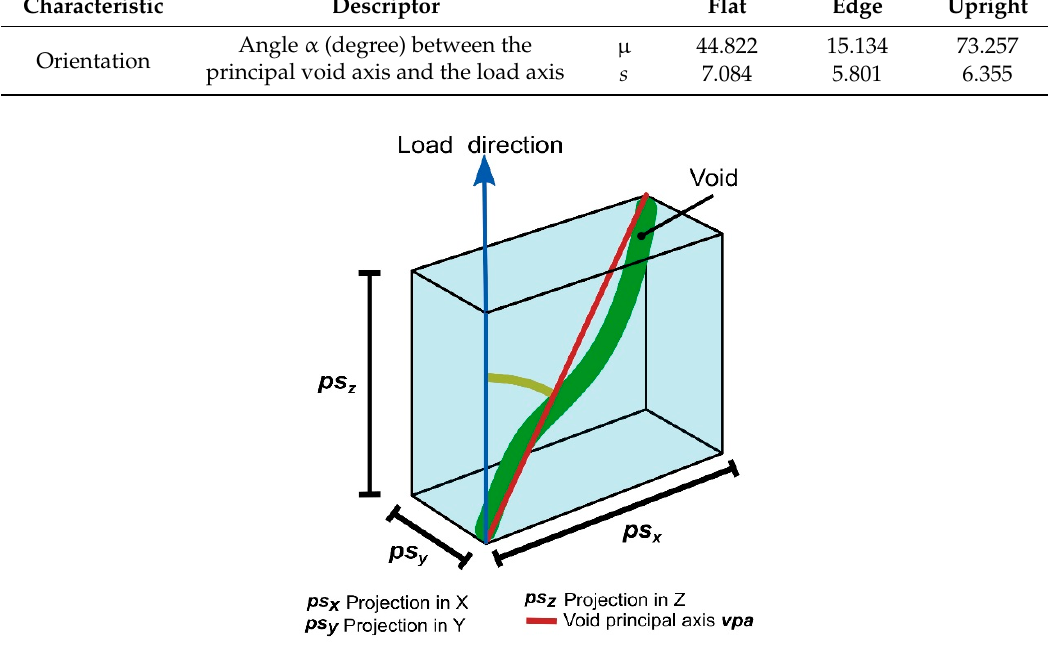
6.355 Figure 7. Void size ( d ) and orientation angle ( α ) relation. The black line indicates the CT resolution limit due to the used parameters and sample size. 3.3. Sensibility and Specificity Voids with an orientation angle in the range { α : α > μ ( α ) + s ( α )} or { α : α < μ ( α ) − s ( α )} according to the corresponding build direction are likely misrelated to a distinct build direction. To validate the mean void orientation angle range for every sample, the sensitivity λ [81] is calculated for the established range. The value of λ is a statistical measure that gives the percentage of void angles correctly identified within the established angle range. For every orientation, e , f , and u , there is a collection A ( α ) of measured void angles with mean μ ( α ) and s( α ) standard deviation corresponding to that orientation, and A ¬ ( α ) (w.r.t. μ ¬ ( α ),s ¬ ( α )) and A ¬ ( α ) (w.r.t. μ ¬ ( α ),s ¬ ( α )) corresponding to the other two collections. To calculate λ , the following Equation is used: